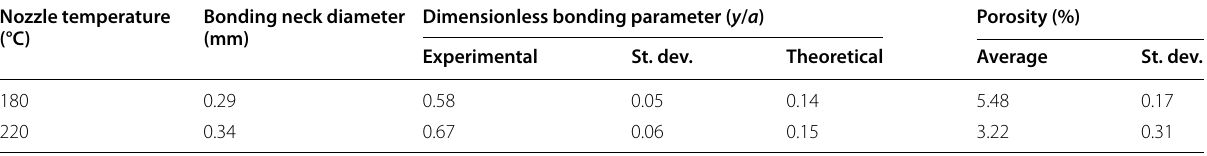
Table 3 Theoretical and experimental values of the bonding neck of printed parts Nozzle temperature Bonding neck diameter Dimensionless bonding parameter ( y / a (°C) (mm)